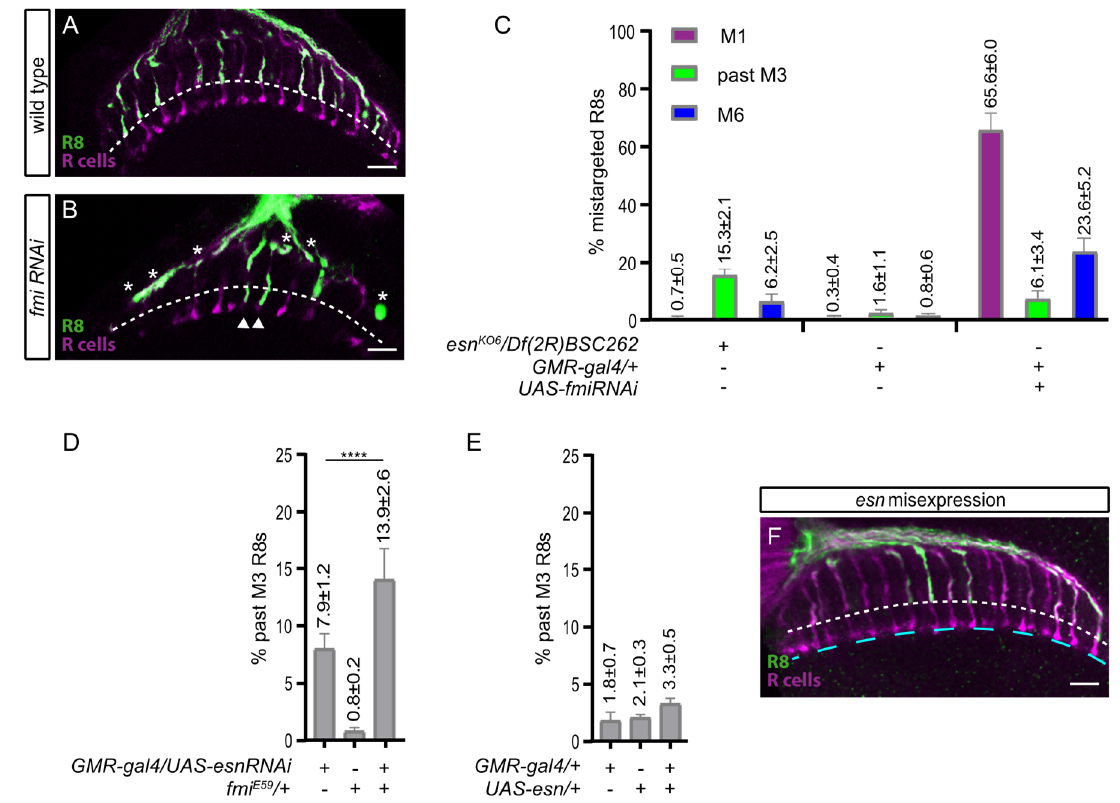
Figure 3. Contribution of the esn / fmi genetic interaction to R8 final layer selection. All images are confocal sections of adult photoreceptor arrays (magenta) with labeled R8 axons (green) as in Figure 2. ( A ) Control animals with R8 axons terminating in the M3 layer (dashed line). ( B ) Array of an all-photoreceptor fmi knockdown animal. Asterisks mark R8 axons that get stuck in the M1 layer at the edge of the medulla. Arrowheads mark two columns where R8 axons extend past the M3 layer, almost to the M6 layer, where R7 axons (magenta) terminate. ( C ) Graph showing the percentages of mistargeted R8 axons to the M1 layer, past the M3 layer, and almost to the M6 layer in the esn mutant; a control for the fmi RNAi knockdown, and the fmi RNAi knockdown. ( D ) Graph showing the increase in the percentage of past M3 mistargeted R8 axons observed as a result of the esn / fmi genetic interaction. ( E ) Graph showing that overexpression of esn in the R8 does not a ff ect R8 layer selection. The small percentage of mistargeted R8 axons observed is a result from the additive e ff ect of heterozygous controls. ( F ) Adult array of an animal expressing esn in all-photoreceptors. R8 axons terminate in the M3 layer (white dashed line). R7 axons terminate in the M6 layer (lower cyan dashed line). **** p < 0.0001. Scale bars 10 microns.